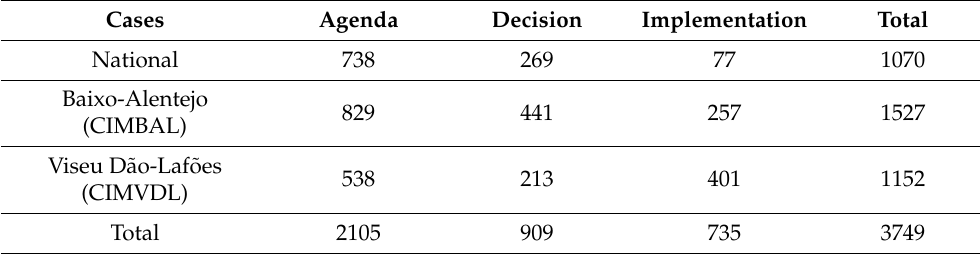
Figure 4. Snapshot of the NVivo Software. Source: the authors. The breakdown of the 3749 coding units (by stage and case) is shown in Table 1. Table 1. Quotes per Stage and Case Study.